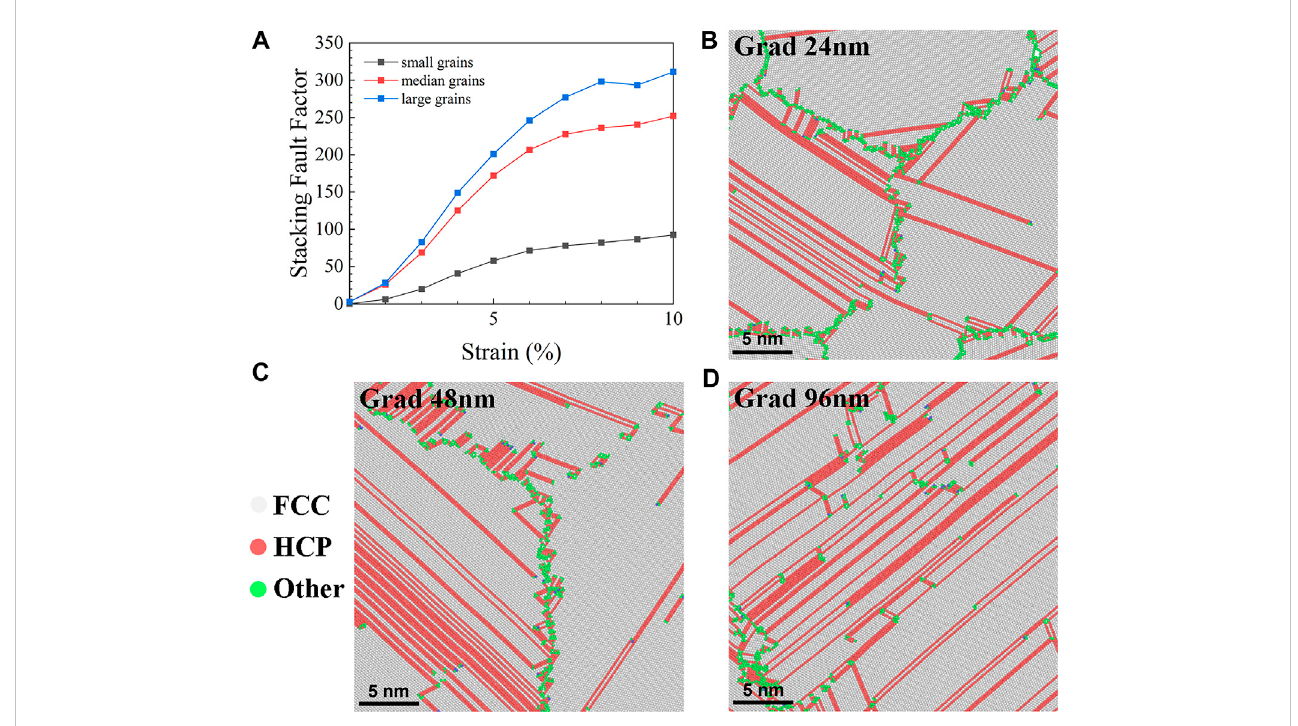
FIGURE 5 (A) Grain size dependency of stacking fault factor in GNG structured model. (B – D) Typical stacking fault pattern of 24, 48 and 96 nm grains in GNG structured model at applied tensile strain of 10%.